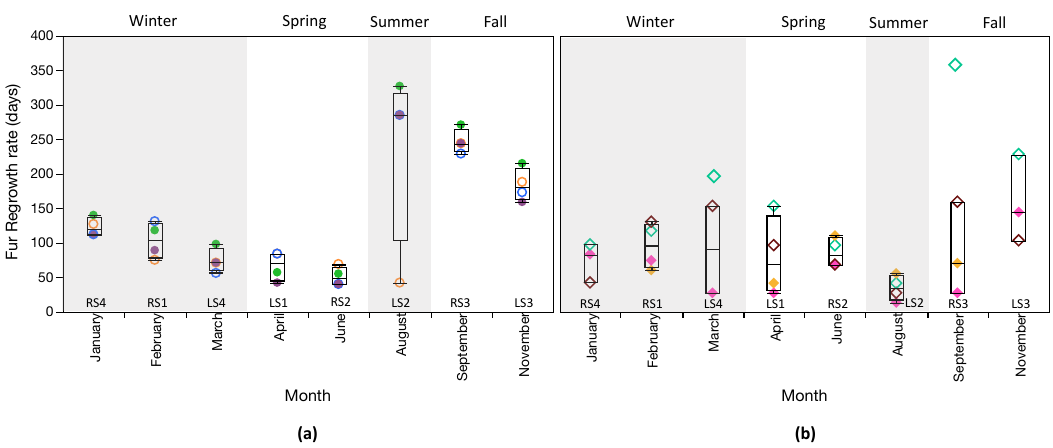
Figure 4. Box plots comparing regrowth among shaves done in di ff erent months for: ( a ) dwarf lemurs and ( b ) mouse lemurs. Boxes represent 25 and 75% quartiles, and whiskers contain 1.5 times the interquartile range. Measurements for Poblano’s RS3 (September 2017) and LS4 (March 2018) are shown but excluded from box plots and statistical comparisons. Symbology corresponds with Figures 1 and 2. Males are open symbols; females are closed symbols.